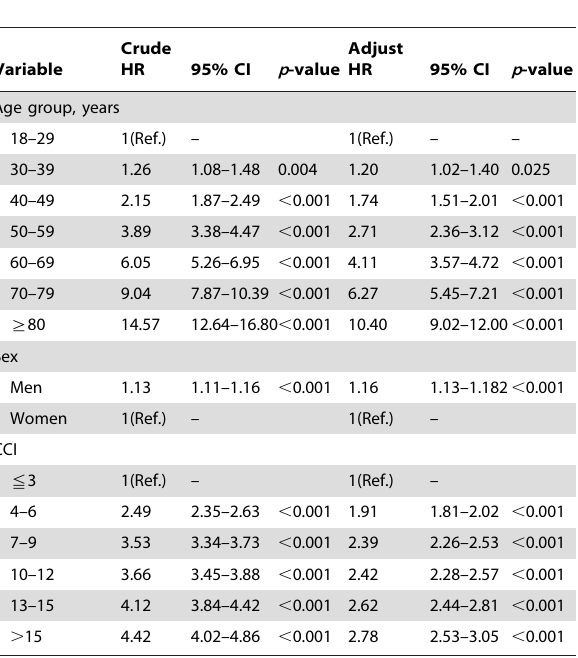
Table 2. The effect of age and CCI on the survival of dialysis patients by cox regression (univariate and